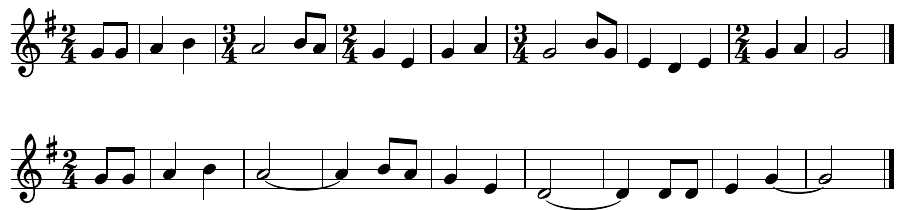
Figure 6. ( Top ): Chippewa lullaby ID102, recorded on the White Earth Reservation ([7], p. 163). ( Bottom ): Chippewa lullaby ID447, recorded on the Red Lake (Lac du Flambeau) Reservation ([8], p.